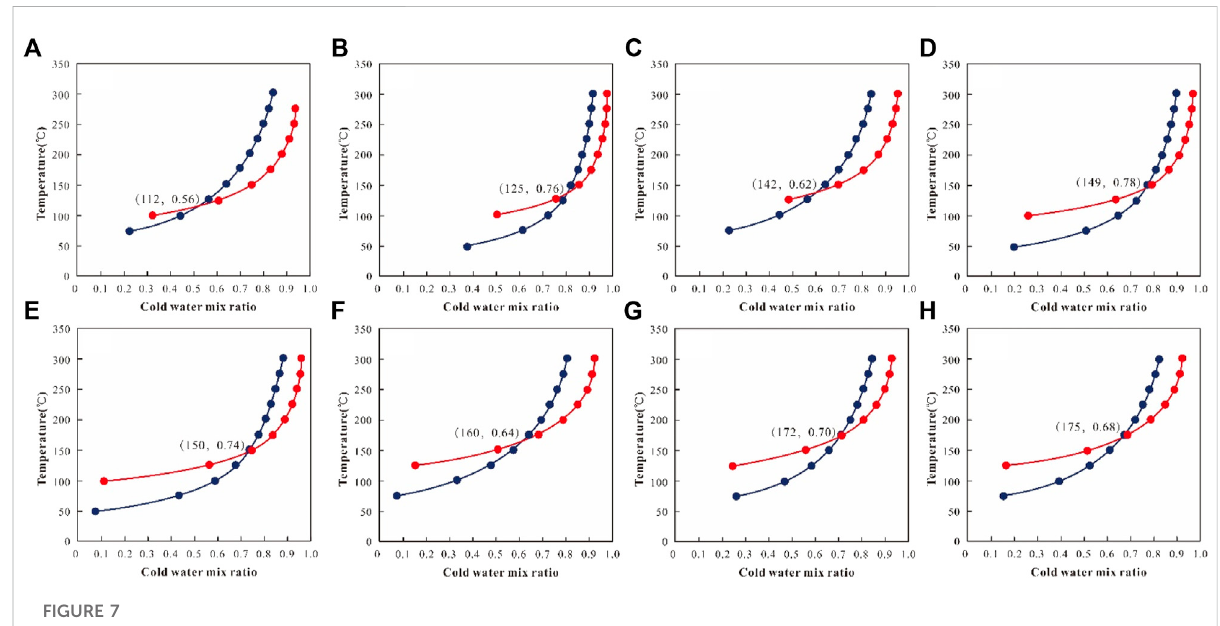
FIGURE 7 Relationship between temperature and cold-water mix ratio (A-H) .